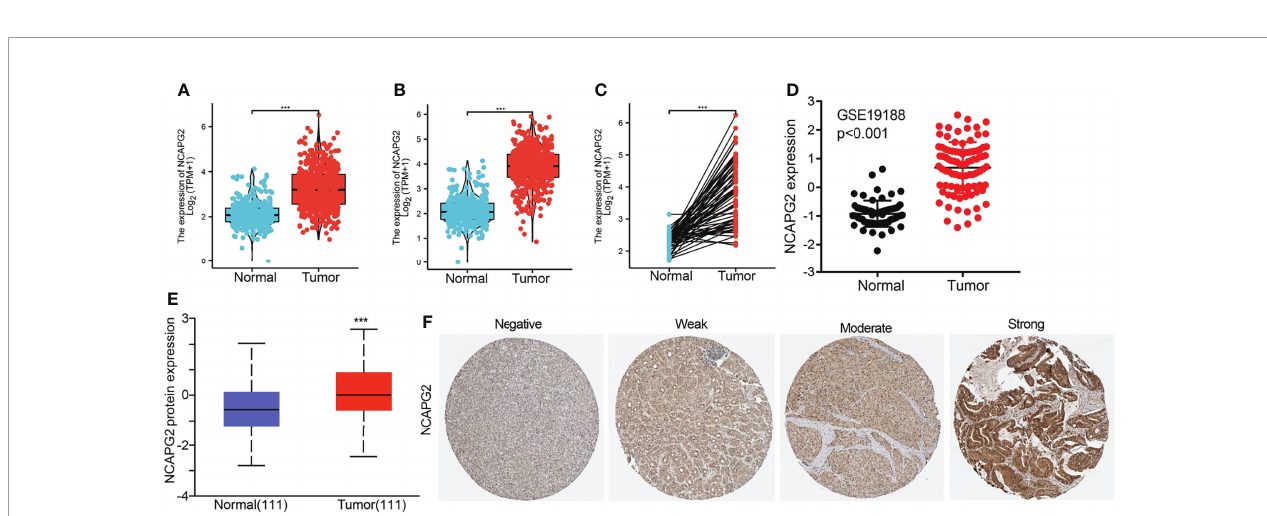
FIGURE 2 | NCAPG2 RNA and protein expression in LUAD. (A – C) NCAPG2 mRNA expression levels in lung cancer patients and matched adjacent normal samples. (D) The expression level of NCAPG2 in lung cancer was determined by the GEO dataset. (E, F) NCAPG2 protein expression level based on CPTAC and Human Protein Atlas. *** p <0.001.